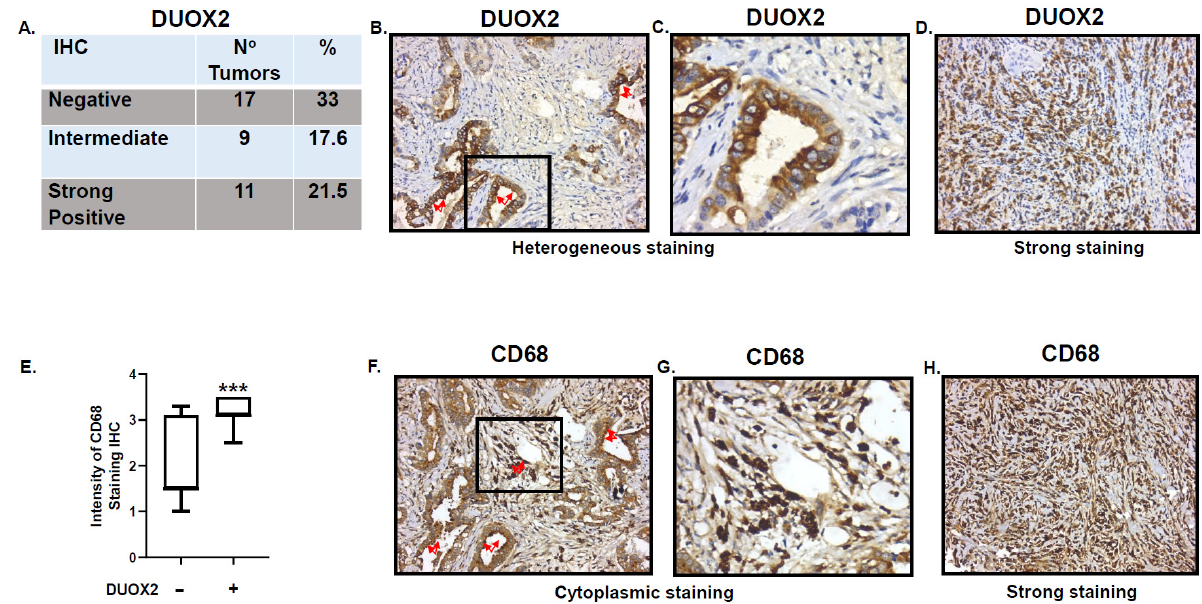
Figure 6. Immuno-Histo-Chemistry (IHC) in 37 human adenocarcinoma samples. ( A ) Staining scored blinded by a pathologist at Pantomics, Inc. Staining > 2.8 was considered strong DUOX2 positive, score of “0” was considered DUOX2 negative. Percentage of strong staining and negative DUOX2 staining are indicated. ( B ) Example of heterogeneous (positive and negative) DUOX2 staining in well differentiated/low grade gastric adenocarcinoma (Malignant 1). Red arrows indicate cells expressing DUOX2. ( C ) Expanded view of inset from ( B ). ( D ) Example of strong DUOX2 staining in poorly differentiated/high grade stomach adenocarcinoma. ( E ) Intensity of CD68 staining in DUOX2 negative and positive samples. Student’s t -test, *** p = 0.0005. ( F ) CD68, red arrows indicate macrophages tumor and stroma infiltration in same tissue as ( B ) expressing DUOX2. ( G ) Expanded view of inset from ( F ). ( H ) IHC in poorly differentiated/high grade stomach adenocarcinoma showing strong CD68 staining. Images dimensions are 450 × 383 pixels (W × H).